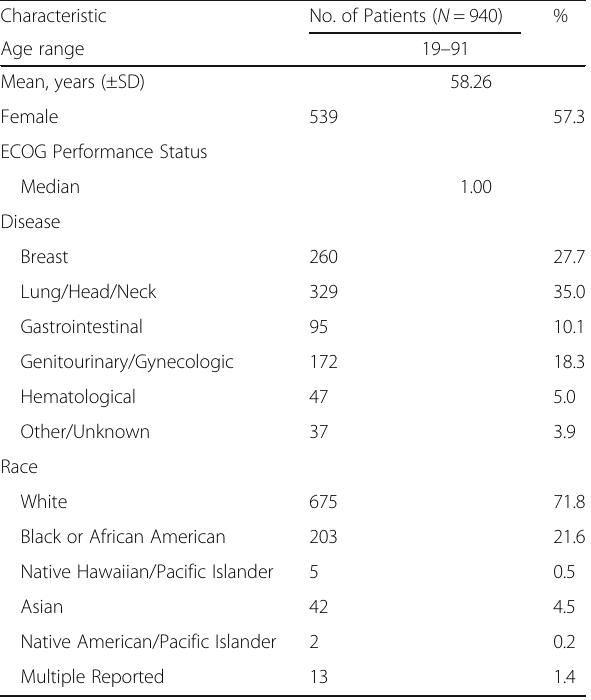
Table 2 Patient characteristics ( N = 940)